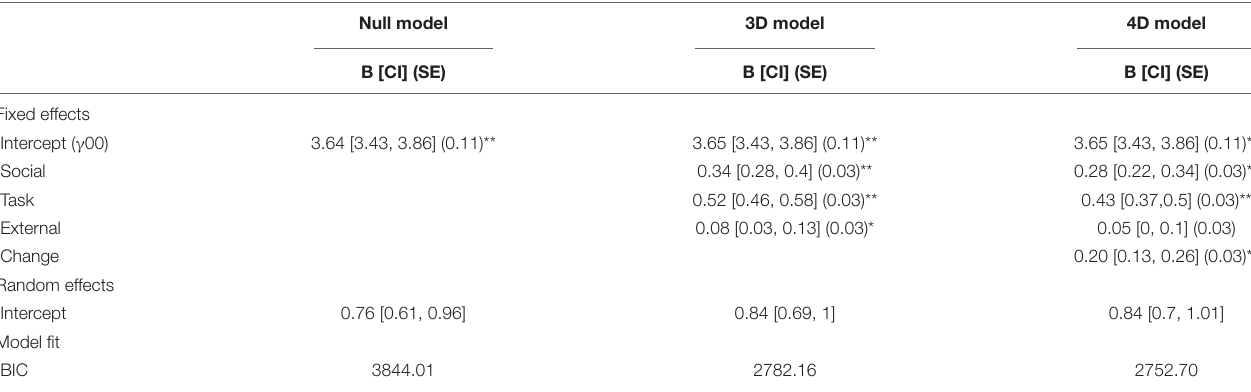
TABLE 4 | Multilevel regression models: estimates and fit